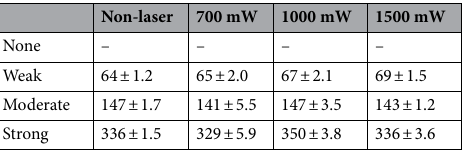
Table 1. Melanin concentration of artificially pigmented cells